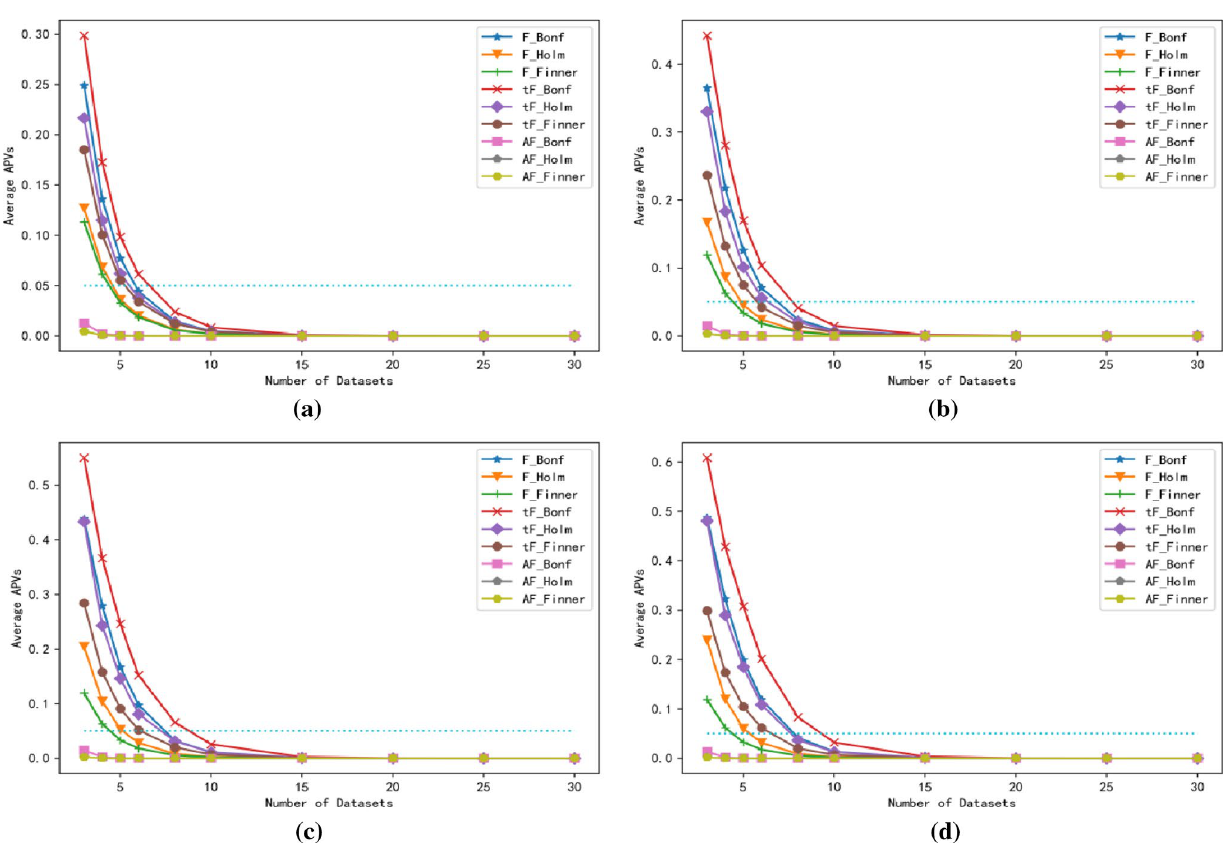
Fig. 8 Average APVs of different nonparametric statistical tests under the experiment setting iii: a the number of algorithms K = 4; b K = 6; c K = 8; d K =